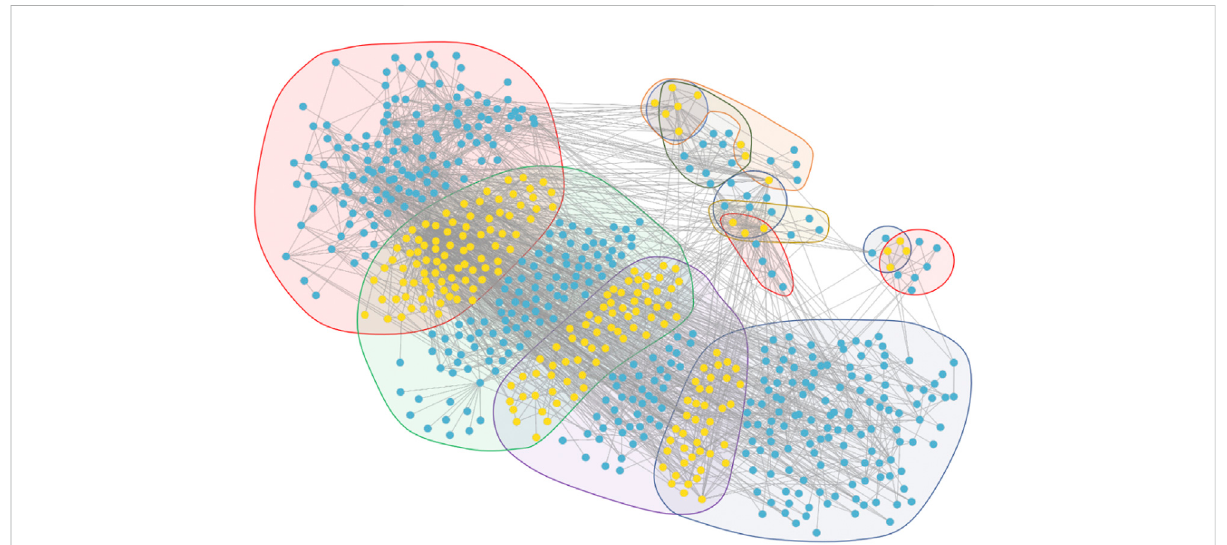
FIGURE 12 Module overlap visualization. The vertices in the visualization contain yellow vertices and blue vertices. The yellow vertices are the intersection of biological molecules of the modules, while the blue vertices are not the intersection. The background regions in different colors represent different modules. The four large regions represent the four largest core modules, corresponding to the four stages which, through GSEA, do not obtain accurate results. The other eight small regions represent the eight core modules which, through GSEA and selection, reveal the core biological